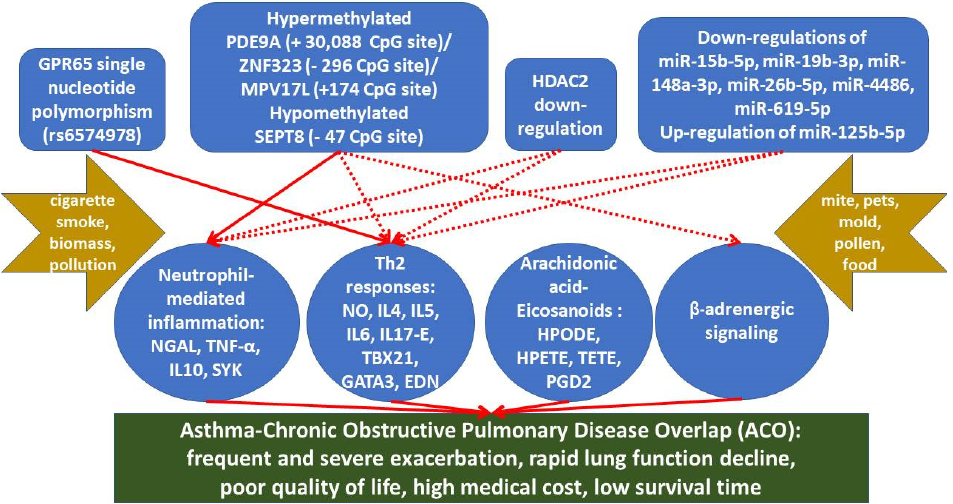
Figure 1. Proposed model of the roles of epigenetics-mediated regulations in the development of asthma and chronic obstructive pulmonary disease overlap (ACO) and its clinical phenotypes. Continuous lines and arrows represent proposed cause and effect relationships based on the findings from the cohort studies, in vitro experiments, or animal models, while dotted lines and arrows represent hypothetical relationships not approved by spe- cific investigations in ACO.